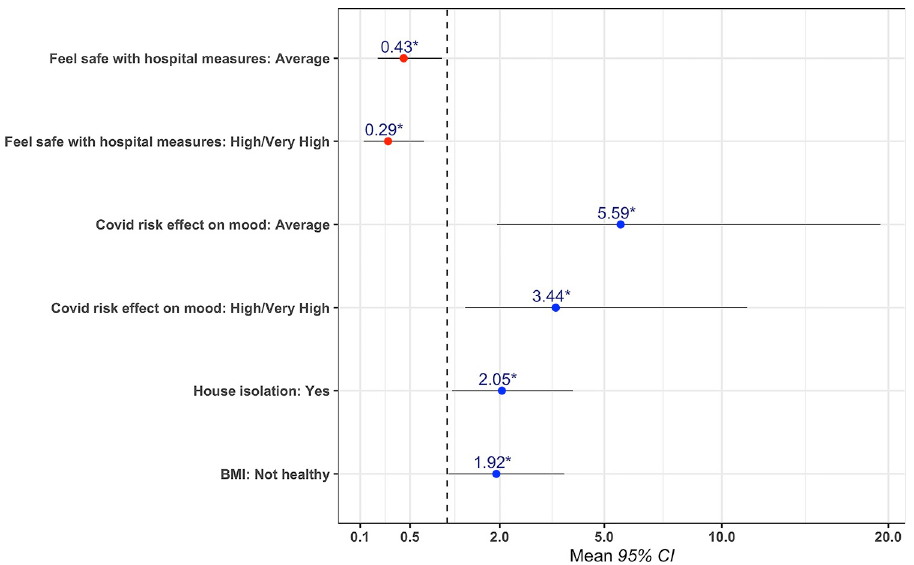
Fig 5. Multivariable logistic regression model identifying factors associated with high levels of burnout.